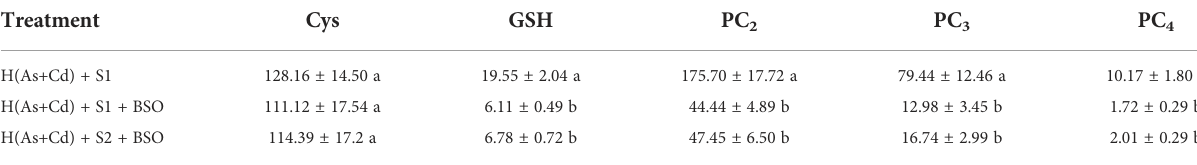
TABLE 3 Concentrations of thiol (-SH) compounds in the roots of wheat plants grown in de fi cient S or suf fi cient S nutrient solution after 6 days of exposure to high As plus Cd with or without BSO (nmol SH g – 1 FW). Treatment